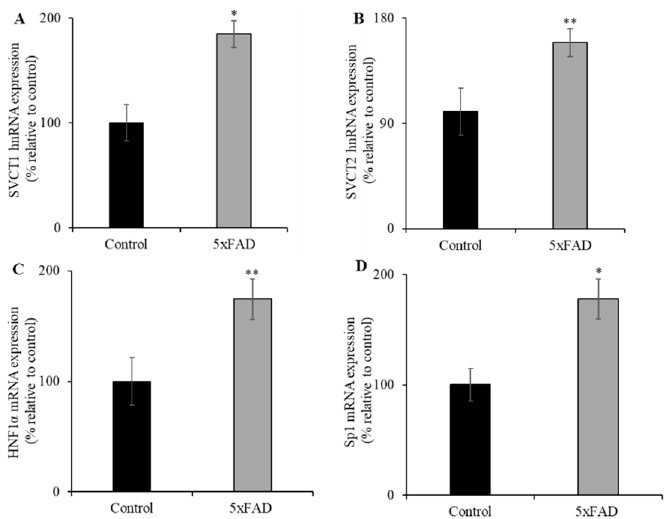
Figure 4. Increased levels of expression of heterogeneous nuclear RNA (hnRNA) and nuclear factors (HNF1 α and Sp1) in 5xFAD mice jejunum mucosa. ( A – D ) RT ‐ qPCR was performed using